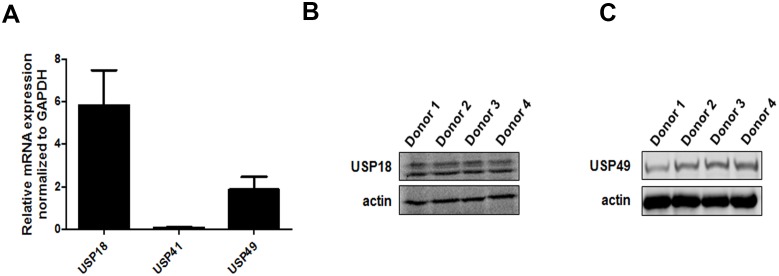
The expression of endogenous DUBs in primary CD4+ T cells.(A) Primary CD4+ T cells were isolated from four healthy donors. The mRNA levels of these DUBs were detected by qPCR with their specific primers. Error bars represent the SEM of three independent experiments. (B) The protein level of USP18 in primary CD4+ T cells was detected by western blotting with indicated antibodies. (C) The protein level of USP49 in primary CD4+ T cells was detected by western blotting with indicated antibodies.